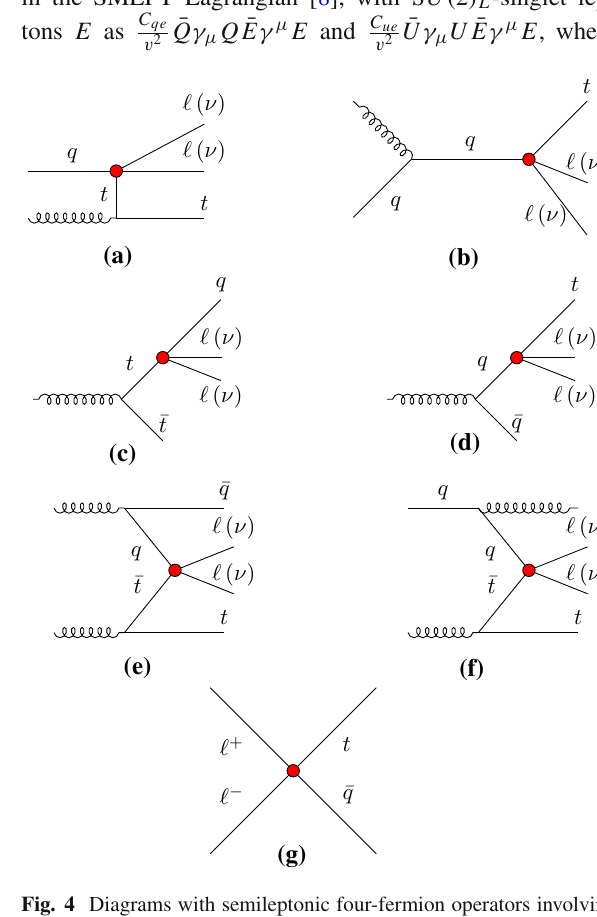
Fig. 4 Diagrams with semileptonic four-fermion operators involving qt (cid:4)(cid:4) (cid:2) or qt ν ¯ ν , q = u , c (red blobs) that contribute to (a)+(b): single top plus dileptons, or single top plus missing energy, wiggly line are gluons, (c)-(f): single top plus jet plus opposite sign dileptons, or single top plus jet plus missing energy. Wiggly lines are gluons, suitable to hadron collider study, or electroweak gauge bosons γ, Z , which can also contribute at a lepton collider (c)+(d). Contribution g) matters only for lepton colliders, with (cid:4) + (cid:4) − annihilating into t ¯